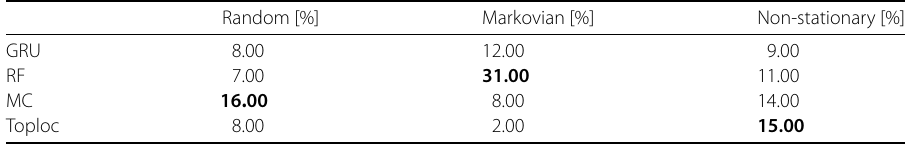
Table 2 A relative number of cases when prediction accuracy of four different prediction algorithms surpasses the predictability limit calculated for the three types of synthetic sequences Random [%] Markovian [%] Non-stationary [%]